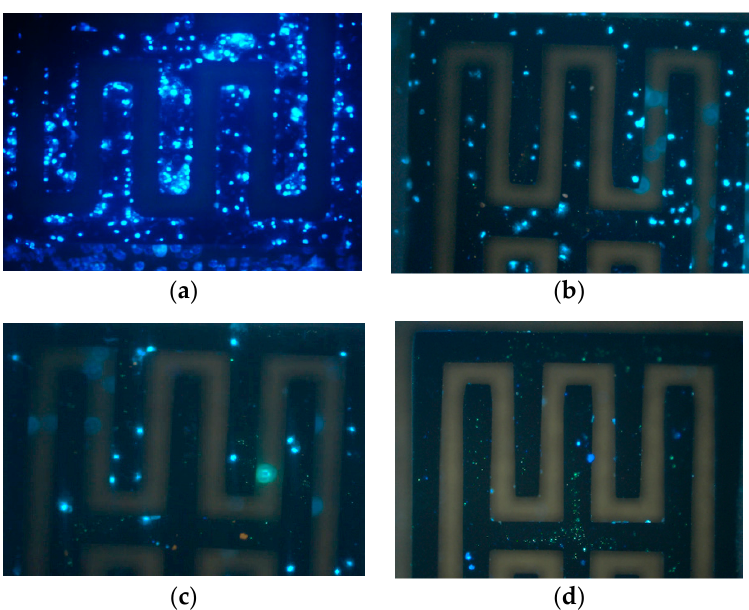
Figure 10. Inverted fluorescence microscope (IFM) images at di ff erent concentrations: ( a ) 10 6 CFU · mL − 1 ; Figure 10. inverted fluorescence microscope (IFM) images at different concentrations: ( a ) 10 6 ( b ) 10 5 CFU · mL − 1 ; ( c ) 10 4 CFU · mL − 1 ; ( d ) non-biofunctionalized electrodes that were injected with a CFU ∙ mL − 1 ; ( b ) 10 5 CFU ∙ mL − 1 ; ( c) 10 4 CFU ∙ mL − 1 ; ( d ) non-biofunctionalized electrodes that were injected cell solution of 10 6 CFU · mL − 1 . with a cell solution of 10 6 CFU ∙ mL − 1 .